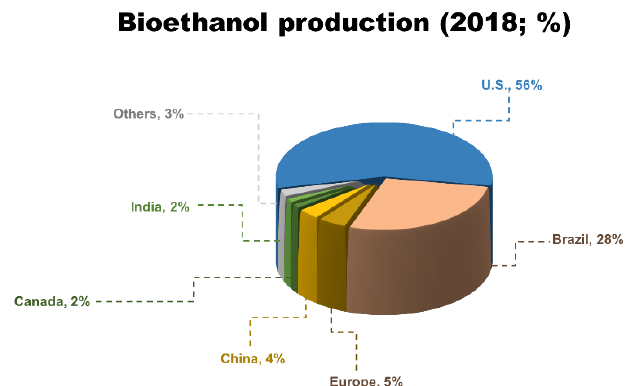
Figure 4. Bioethanol production (%) by the six main producers: the U.S., Brazil, Europe, China, Canada, and India (2018).